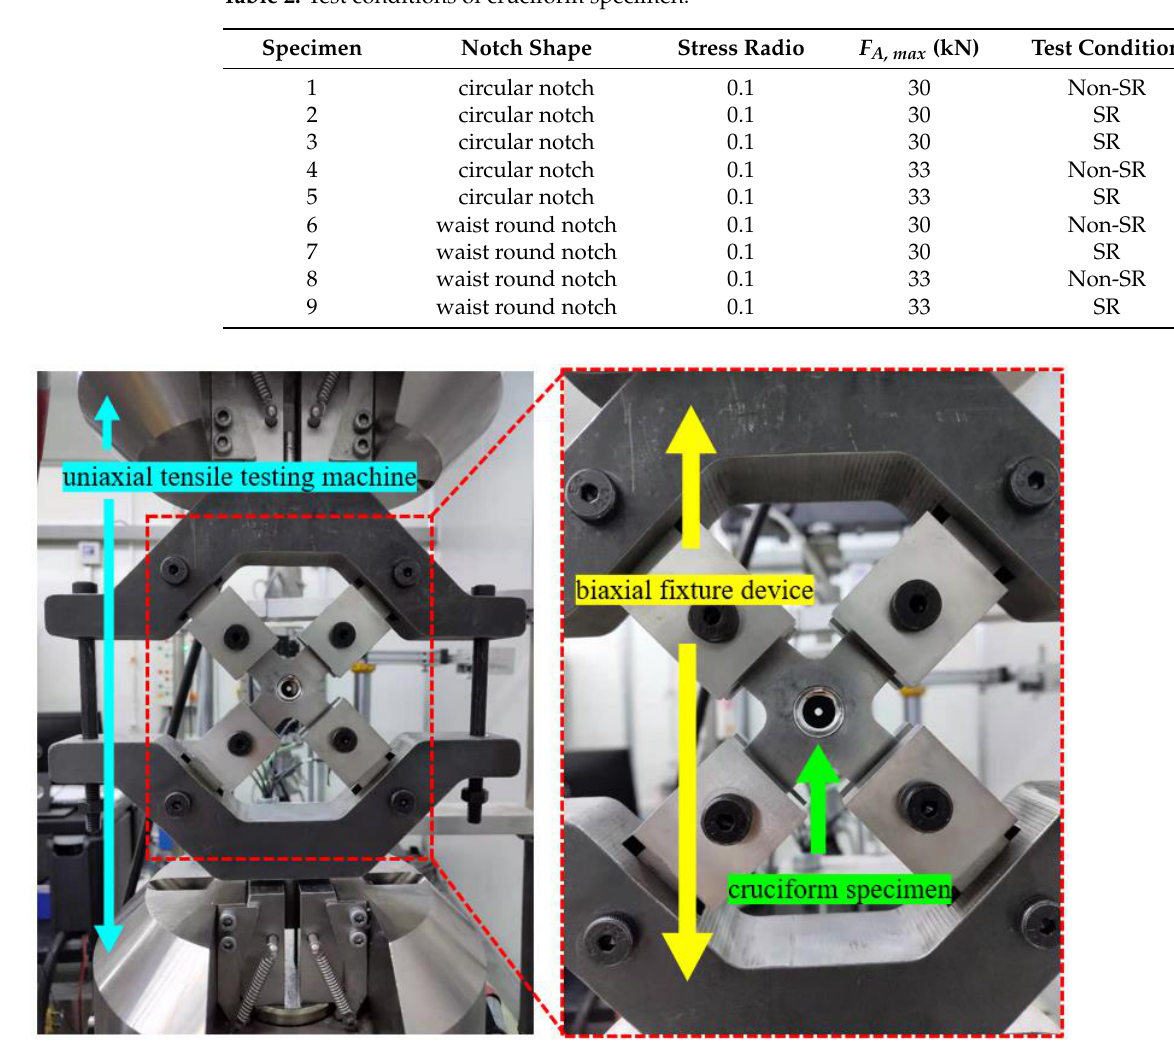
Table 2. Test conditions of cruciform specimen.